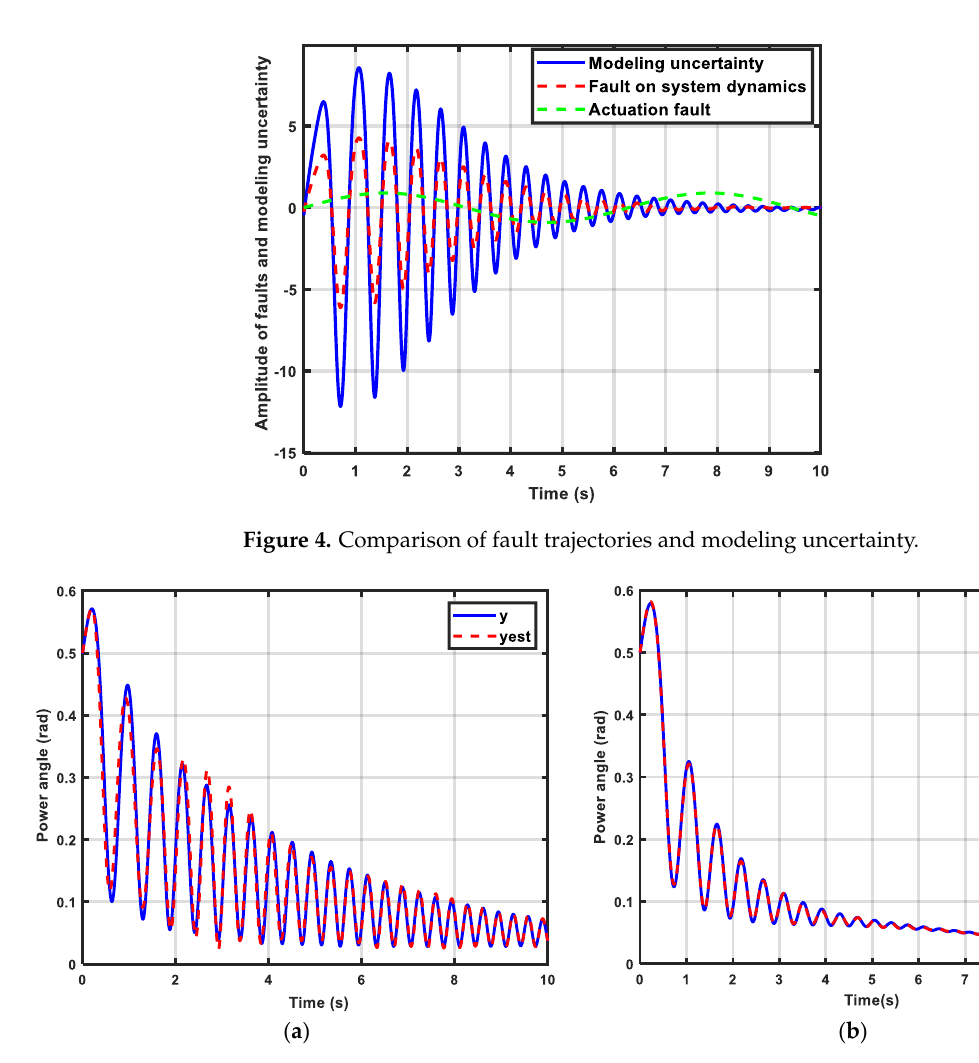
Figure 3. Comparison of SG trajectories in normal and fault modes: ( a ) actuation fault, ( b ) fault impacted on the system dynamics.